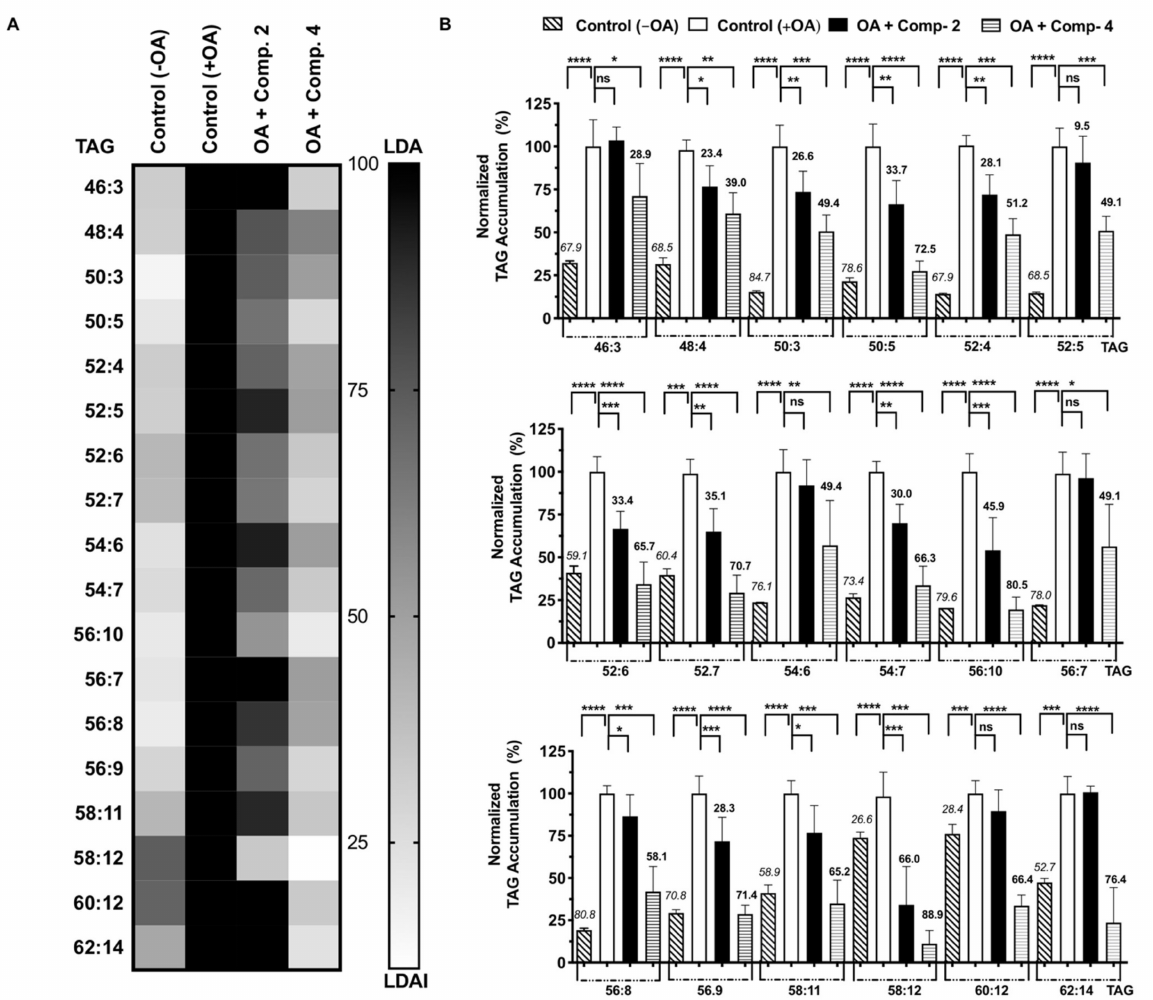
Figure 5. ( A ) Heat map of accumulated and inhibited TAG species in cells; ( B ) Quantification of fluctuation on accumulated TAG species. The italicized and bold values at the top of the columns represent the accumulation and inhibition of each species compared to its negative ( − OA) and positive (+OA) and control, respectively. Graph showing the mean values of the LDA and LDAI (six replications) **** p < 0.0001, *** p < 0.001, ** p < 0.01, * p < 0.05 when compared with the untreated control (+OA) group. ns: not